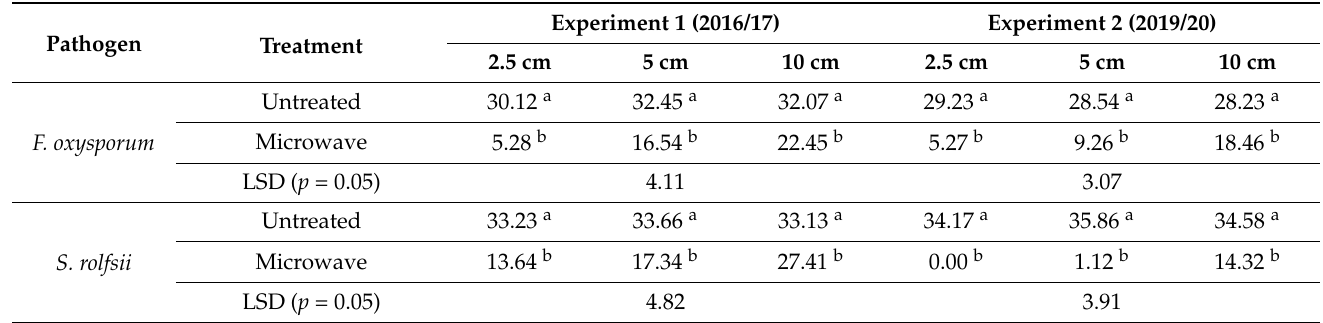
Table 2. Growth (colony diameter, mm) of inoculum of the strawberry pathogens Fusarium oxysporum and Sclerotium rolfsii buried at different soil depths and subsequently grown in the laboratory for five days following treatment with microwave in two field experiments.